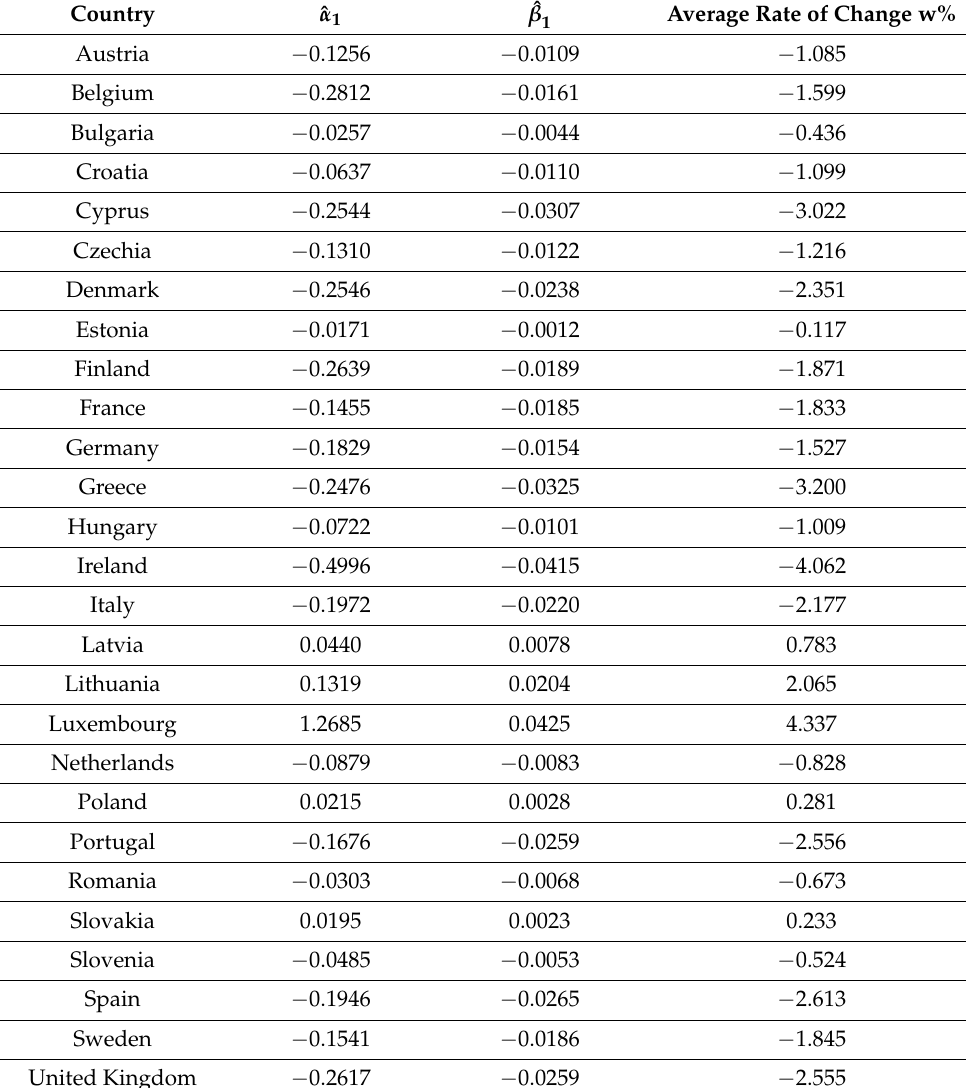
Table 2. Evaluation of the parameters of the trend function of the CO 2 per capita emissions indicator in the years 2000–2018: the average absolute gain (ˆ α 1 ) and the average rate of change ( ˆ β 1 ) . Country ˆ α 1 ˆ β Average Rate of Change w% 1 Austria − 0.1256 − 0.0109 − 1.085 Belgium − 0.2812 − 0.0161 − 1.599 − 0.0257 −